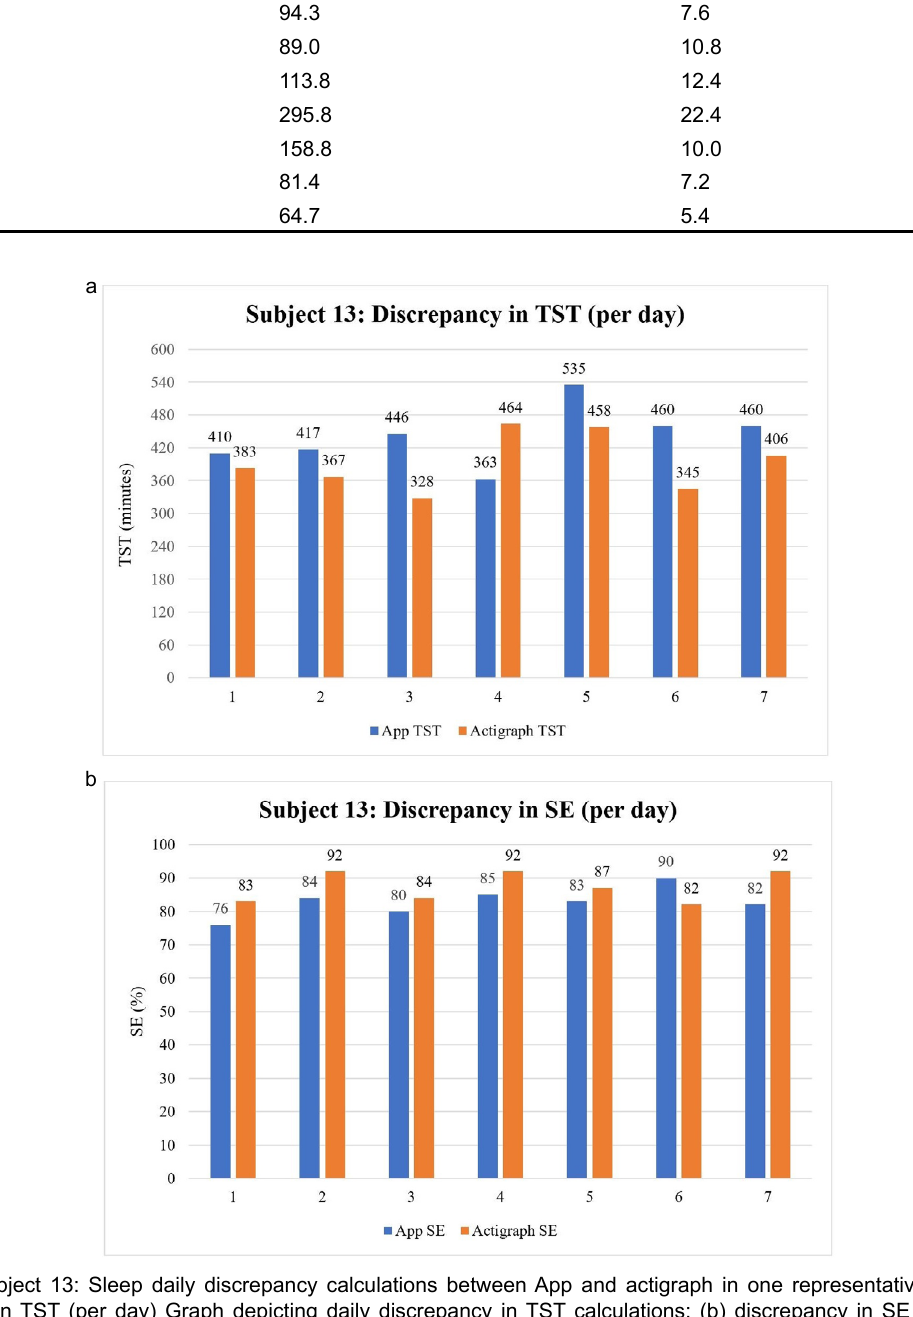
Table 2. Overestimation averages of TST (minutes) and sleep efficiency (%) by participant ( continued ) Participant ID TST